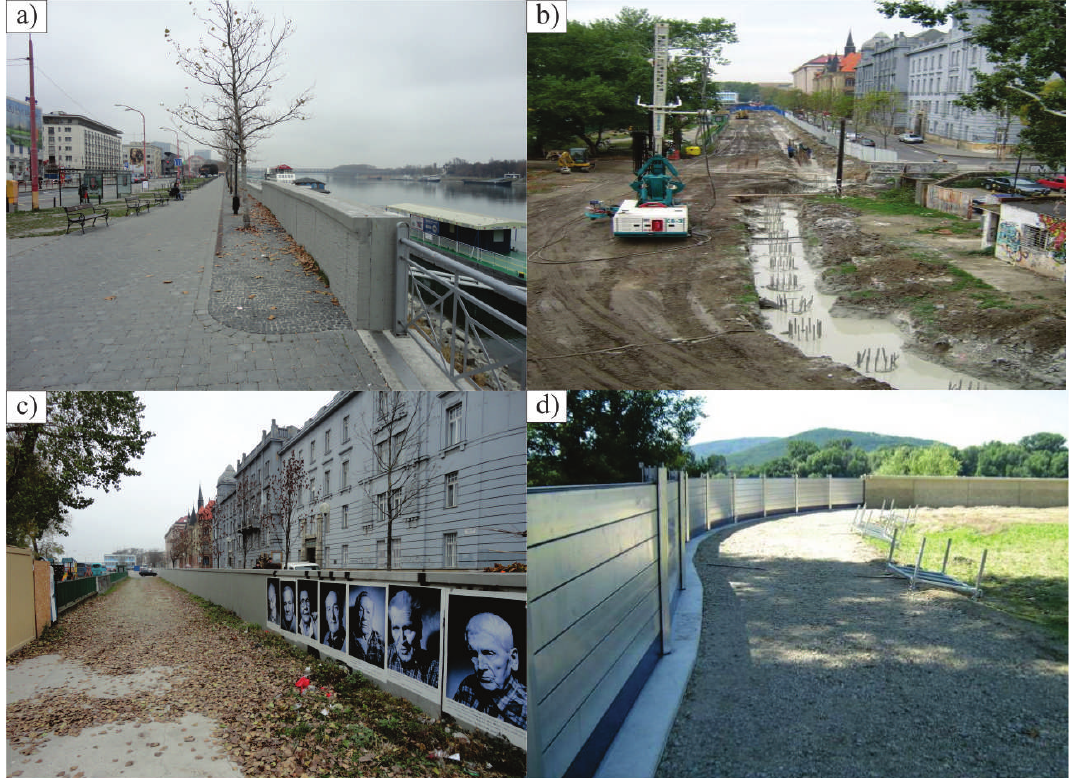
Fig. 5. Various structural flood protection measures in the city of Bratislava, see Table 3; (a) concrete wall, (b) underground sealing wall, (c) reinforced concrete wall, (d) mobile flood wall.